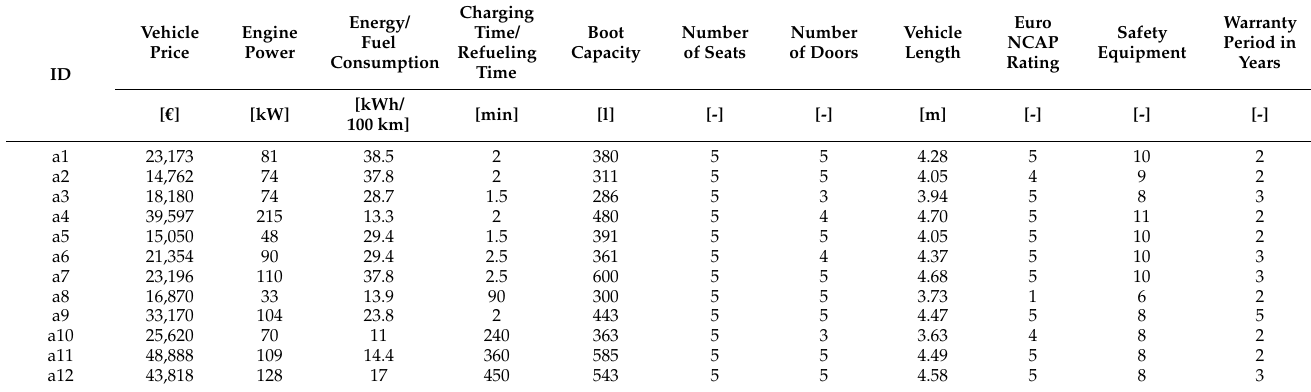
Table 3. Detailed values of individual criteria for each